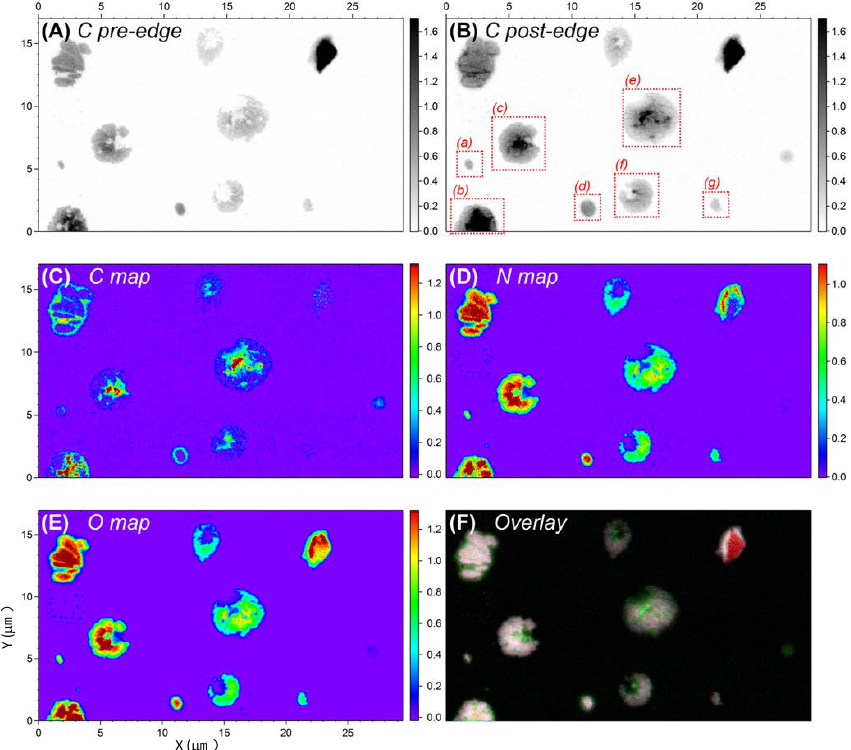
Figure 6. STXM images and elemental maps of representative particles in the coarse mode range with some smaller accumulation mode particles. The particles shown here represent a volume equivalent diameter range of 0.6–1.9µm. (a , b) Carbon pre- and post-edge images, (c) carbon elemental map, (d) nitrogen map, (e) oxygen map, and (f) overlay of C (green), N (blue), and O (red) maps. Axes in (a) – (e) display image dimensions in µm. Optical density (color code) is displayed for individual maps. Red boxes and labels in (b) highlight internally mixed particles with ammoniated sulfate and variable amounts of